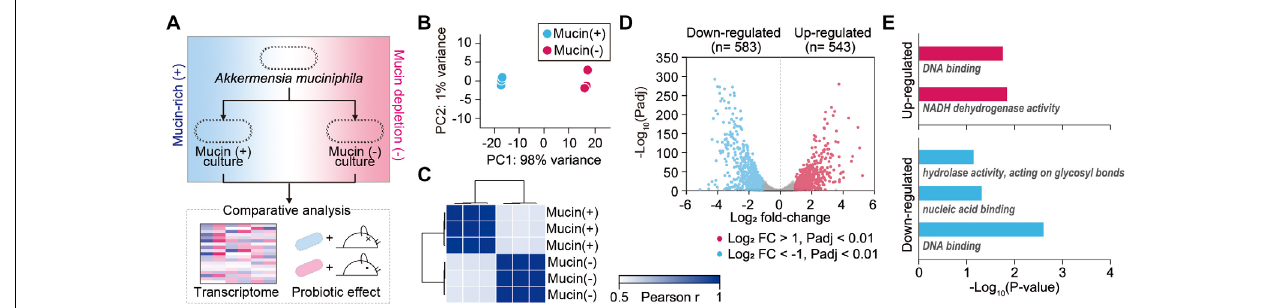
FIGURE 1 | Transcriptomic dynamics of A. muciniphila under mucin-rich and mucin-depleted conditions. (A) Schematic of experimental design employed in this study. (B) Principal component analysis (PCA) of whole-transcriptome RNA data. (C) Sample-to-sample Pearson correlation coefficients between the data sets. (D) Volcano plot of genes sequenced under mucin-rich and mucin-depleted conditions. Differentially expressed genes (DEGs) are in blue. (E) Significantly enriched Gene Ontology (GO) molecular function terms among upregulated (red) and downregulated (blue) differentially expressed genes between mucin-rich and mucin-depleted conditions (Benjamini-Hochberg corrected P < 0.05).